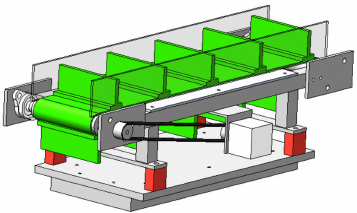
Figure 20. Solution through space separation principle.